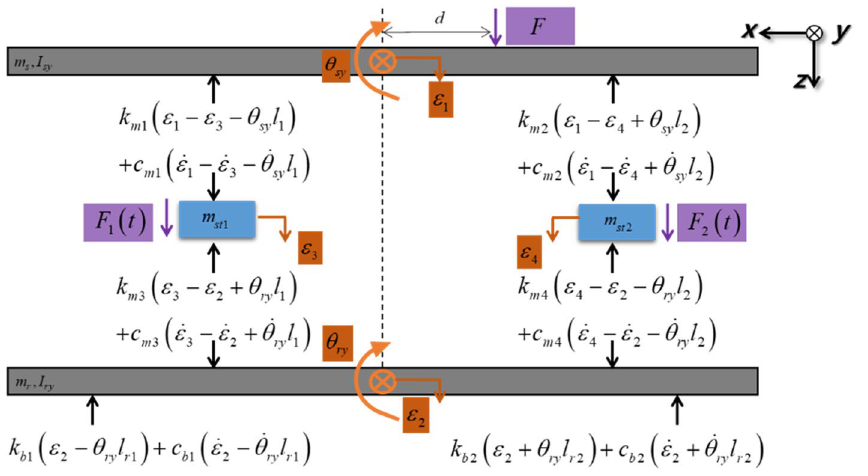
Figure 4. Free-body diagram of the system.